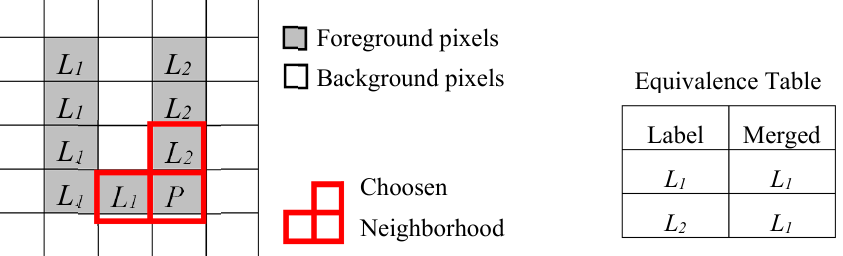
Figure 3. Labeling process for a U-shaped connected component.